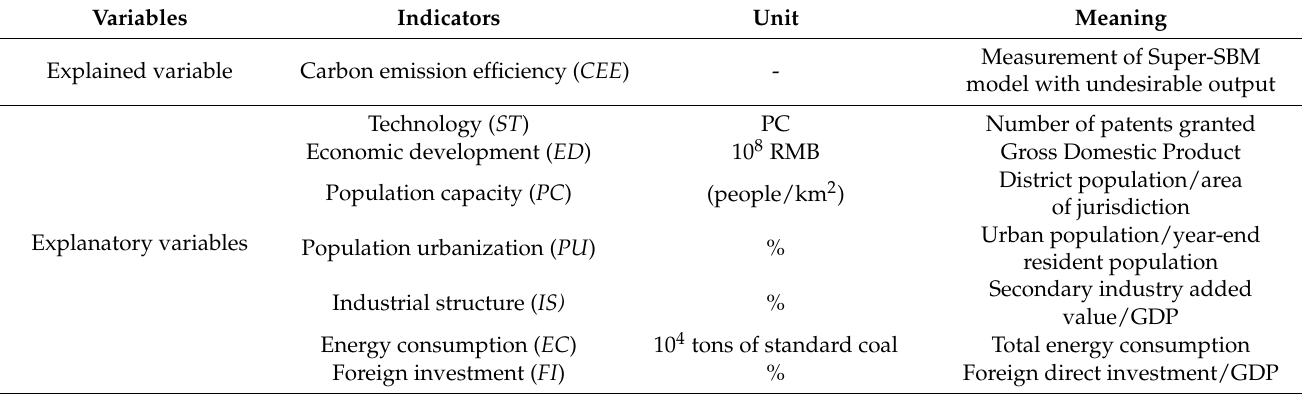
Table 1. Selected variables.